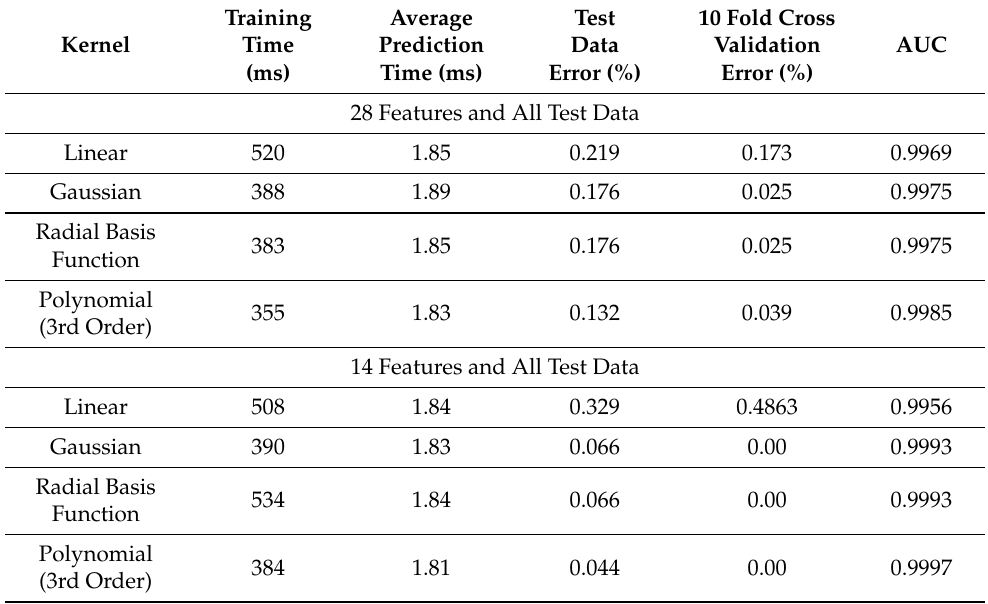
Table 5. SVM Signal Classification Generalization Error Results: ZigBee versus